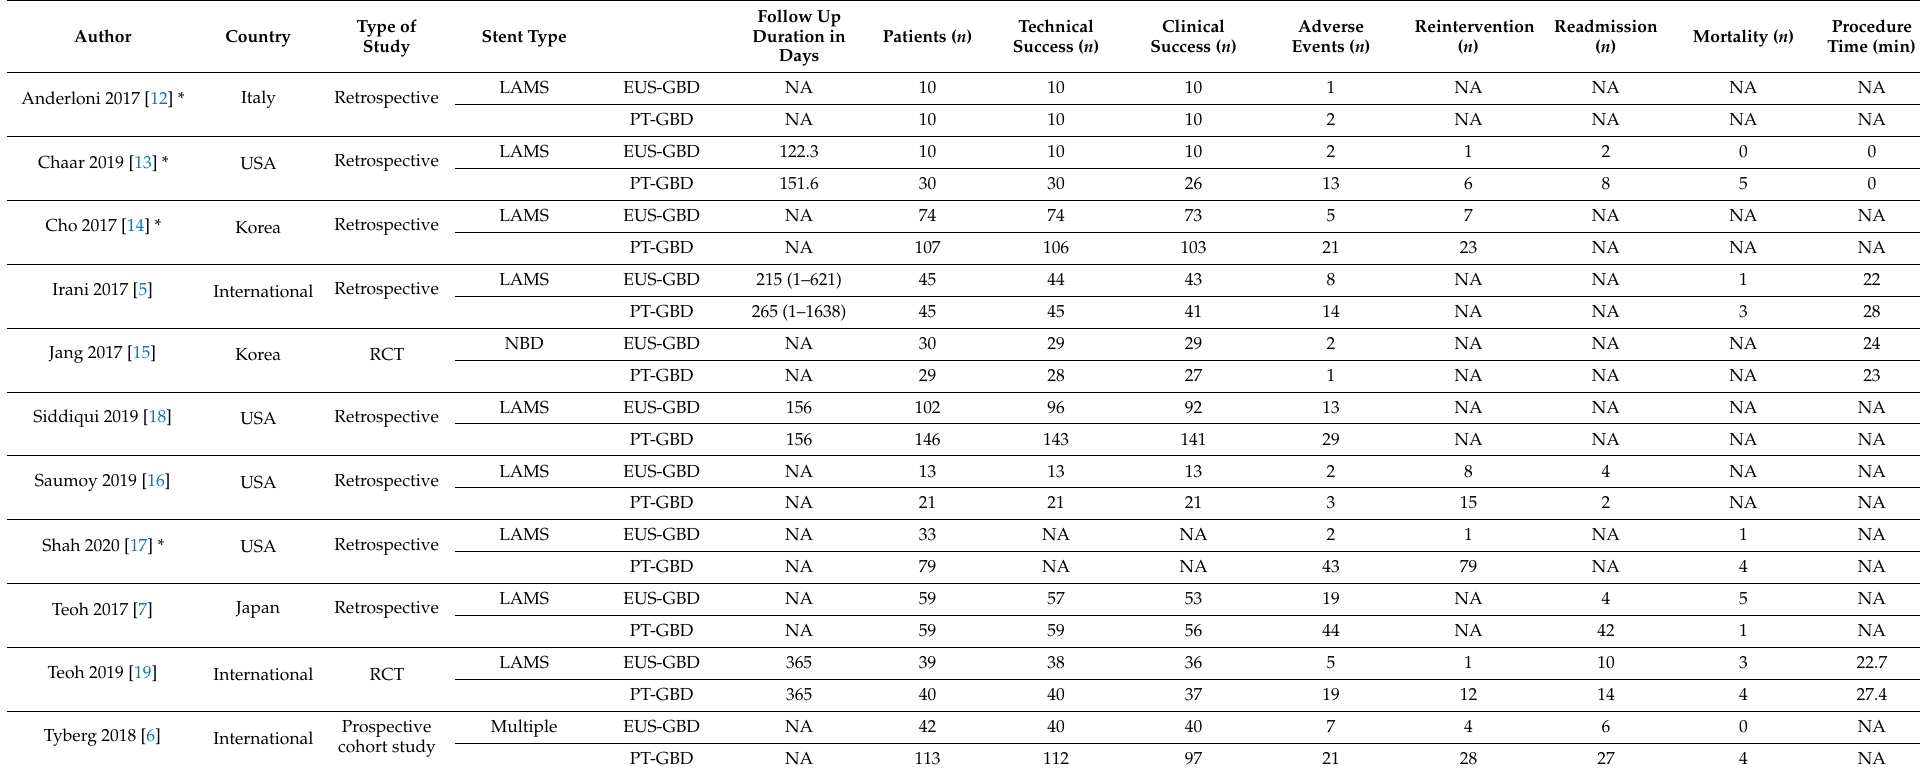
Table 1. Characteristics of studies and events in the treatment and control